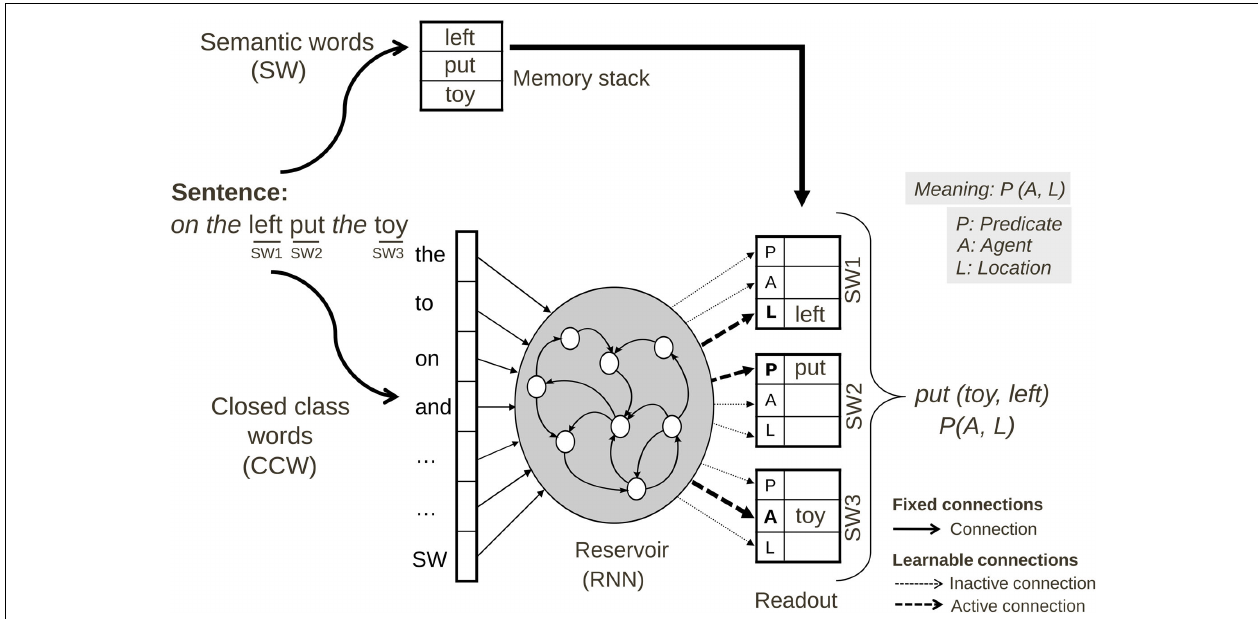
FIGURE 3 | Neural comprehension model for the Action Performing task. Sentences spoken by the user are first transformed into grammatical forms, i.e., all semantic words (SW) are replaced by a SW marker. The reservoir is given the grammatical form word by word. Each word activates a different input unit. Based on training, the readout connections from the